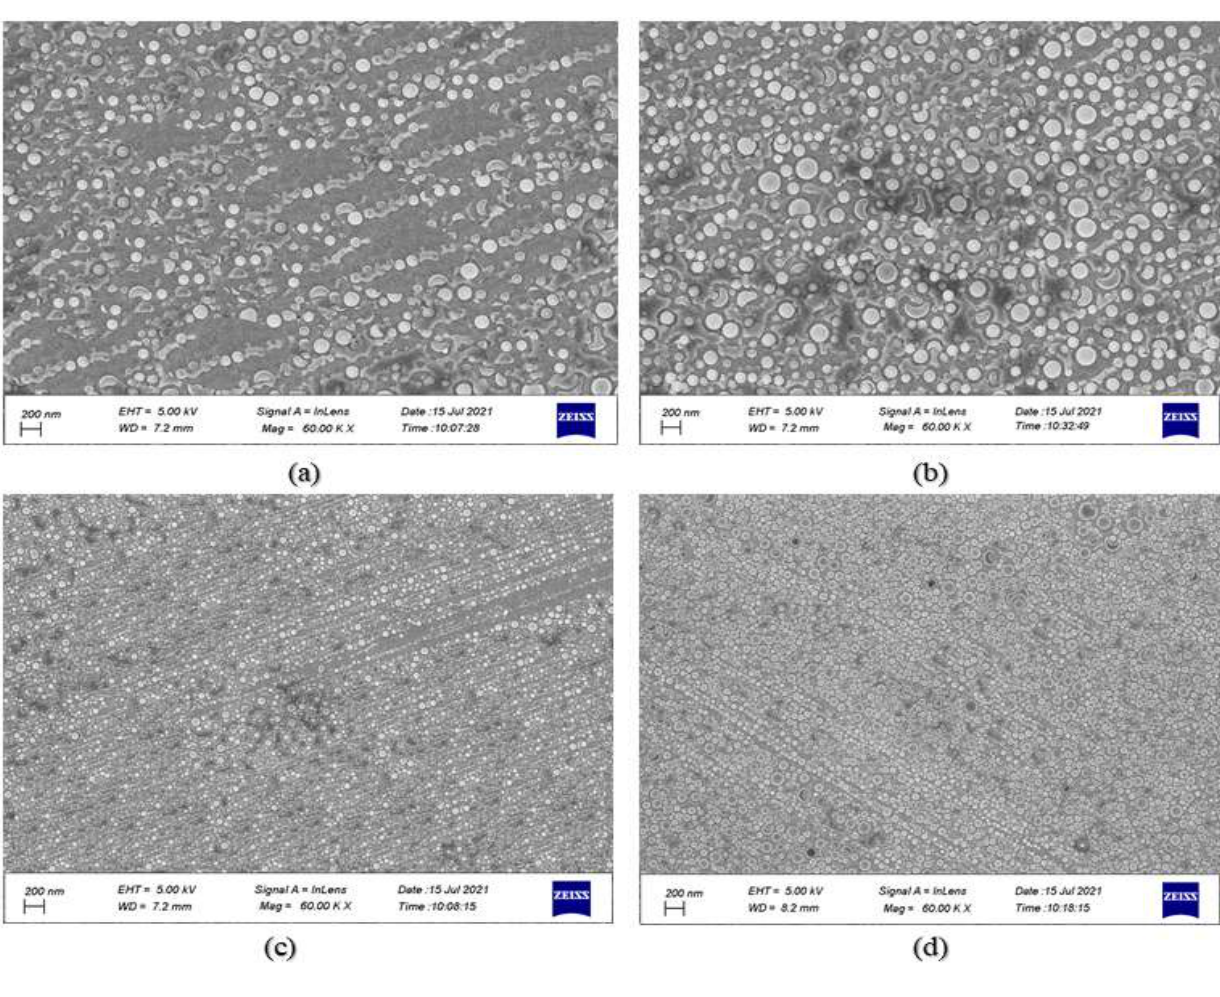
Figure 2: XRD patterns of Ti nanoparticles (a) on glass substrate and (b) on Si (n-type) at 30 min.